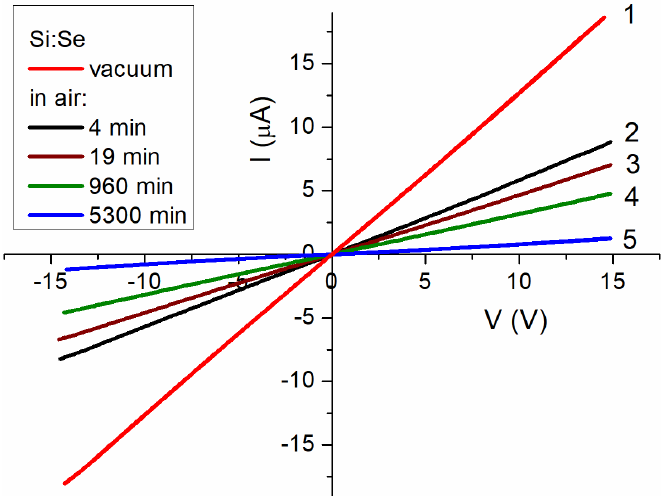
Figure 9. I – V characteristics of Si:Se film measured: ( 1 ) at room temperature in a vacuum; ( 2 ) in air after 4 min of sample contacting the atmosphere; ( 3 ) in air after 19 min; ( 4 ) in air after 960 min; ( 5 ) in air after 5300